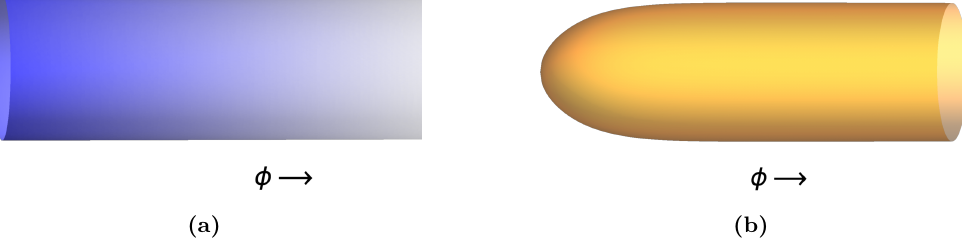
Figure 1. A sigma-model that approaches R φ × S 1 at large positive φ can be regularized (a) by adding a bosonic or N = 1 supersymmetric Liouville potential that grows as φ → −∞ (the blue shading indicates the height of the potential), or (b) by viewing R S 1 as the large φ region of a φ × bosonic or supersymmetric SL (2 , R ) (S)CFT. In both cases, the field φ is prevented from U(1)